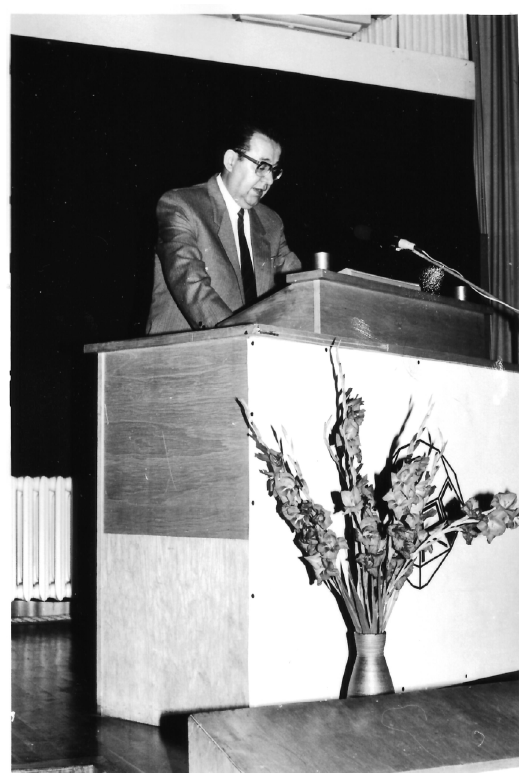
Figure 17. Prof. Stiller gives a talk about the Earth core structure at the European High Pressure Research Group 1987 in Potsdam.